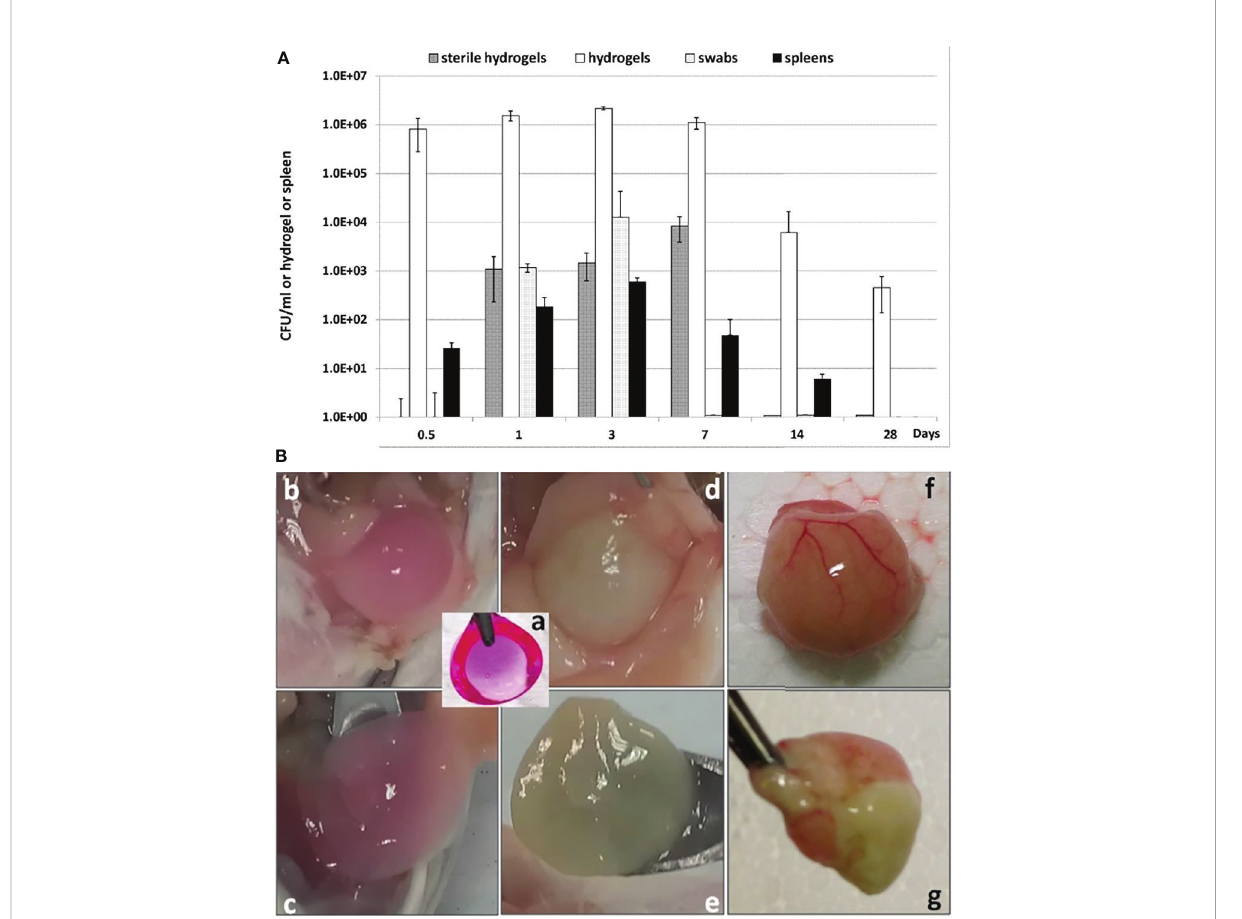
FIGURE 2 Quanti fi cation of P. aeruginosa bacteria present in PF hydrogels harvested from mouse peritoneal cavities (A) and visualization of the harvested PF hydrogels ( B ). (A) Enumeration of the number of bacteria in the infections. All bar charts show the median ± standard deviation (n ≥ 6). Values are shown for bacteria in hydrogels (white bars), spleens (black bars), originally sterile hydrogels (dark gray bars), and peritoneal swabs (light gray-bars). (B) Gross view of PF hydrogels with or without P. aeruginosa harvested from mouse peritoneal cavities. (a) PF hydrogel implant before implantation (color induced by Resazurin sodium); (b, c) sterile PF hydrogel on day 3 after implantation was generally loose and easily collected from the mouse peritoneal cavity; (d, e) PF hydrogel with P. aeruginosa on day 3 after implantation was wrapped by peritoneal omentum and could still be carefully separated; (f, g) PF hydrogel with P. aeruginosa on day 14 after implantation was wrapped tightly by the peritoneal omentum with pus inside, and was impossible to separate from the